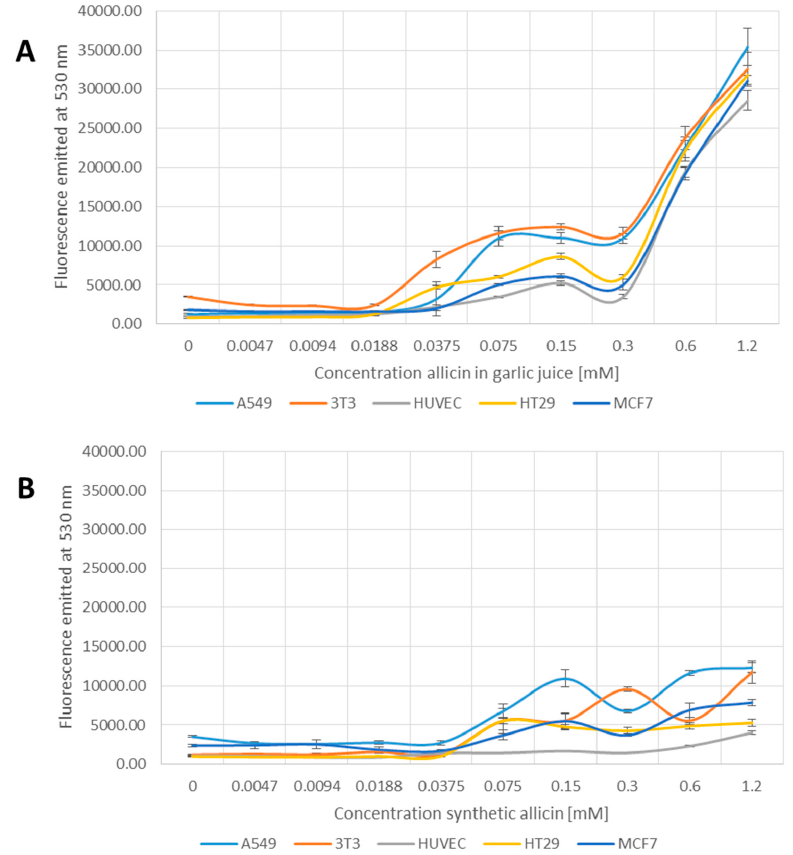
Figure 4. Detection of Reactive Species by 2 ′ ,7 ′ -Dichlorofluoresceine-Diacetate (DCFDA) upon treatment with garlic juice ( A ); or synthetic allicin ( B ). Cells were incubated for 24 h with allicin, washed and treated with DCFDA in DMSO (dimethyl sulfoxide) to a final concentration of 50 µM for 15 min at room temperature, before fluorescence was measured at 530 nm. All data points are means of three replicates; error bars represent standard deviation.